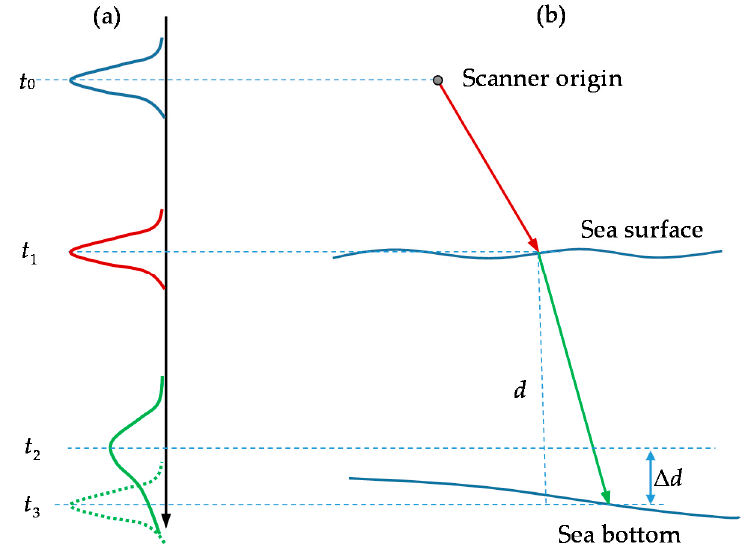
Figure 1. Principle of ALB measurement. d is the water depth. ∆ d is the depth bias induced by peak shifting of the green bottom return. The red and green colors represent infrared (IR) and green lasers, respectively. ( a ) Waveform detections with IR and green lasers; ( b ) propagation ways of the two lasers and the bias induced by peak shifting of the green bottom return; t 0 – t 3 denote the initial emission time of the laser pulse, round-trip time of the IR surface return, round-trip time of the actual received green bottom return distorted by the pulse stretching effect, and round-trip time of the ideal green bottom return, respectively.